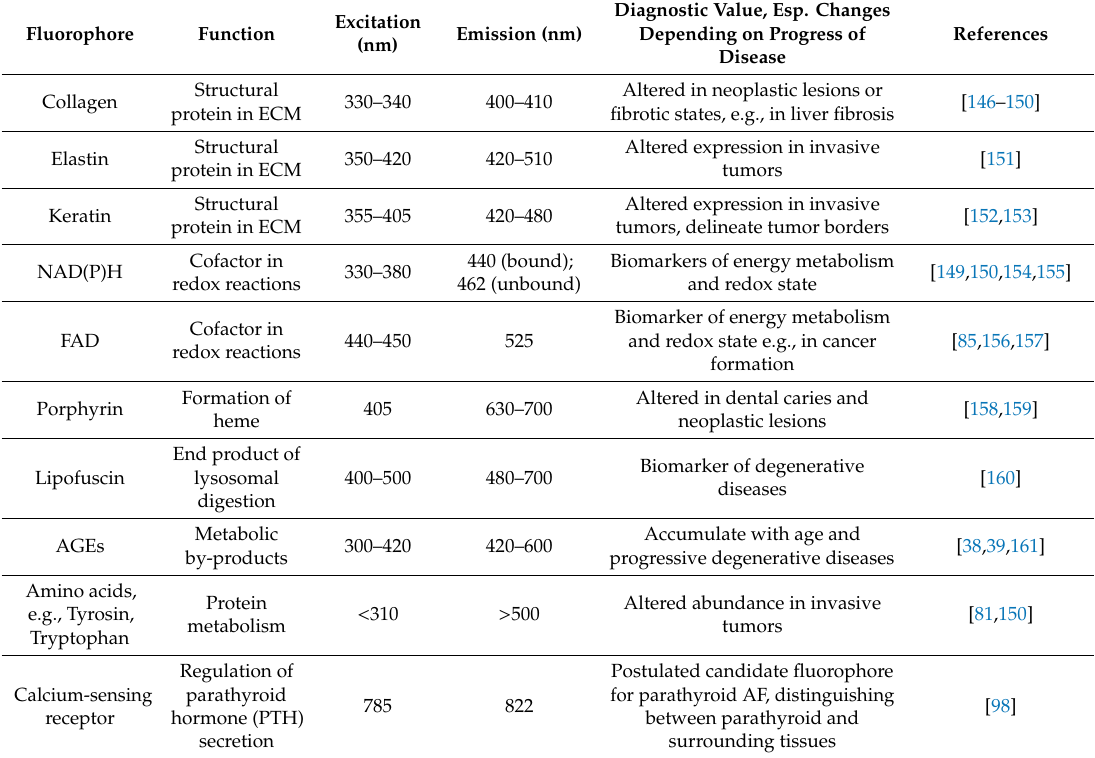
Table 2. Overview and characteristics of commonly known endogenous fluorophores in clinical usage, their typical AF properties, and diagnostic values. All wavelengths are approximate values of the optimal excitation and emission